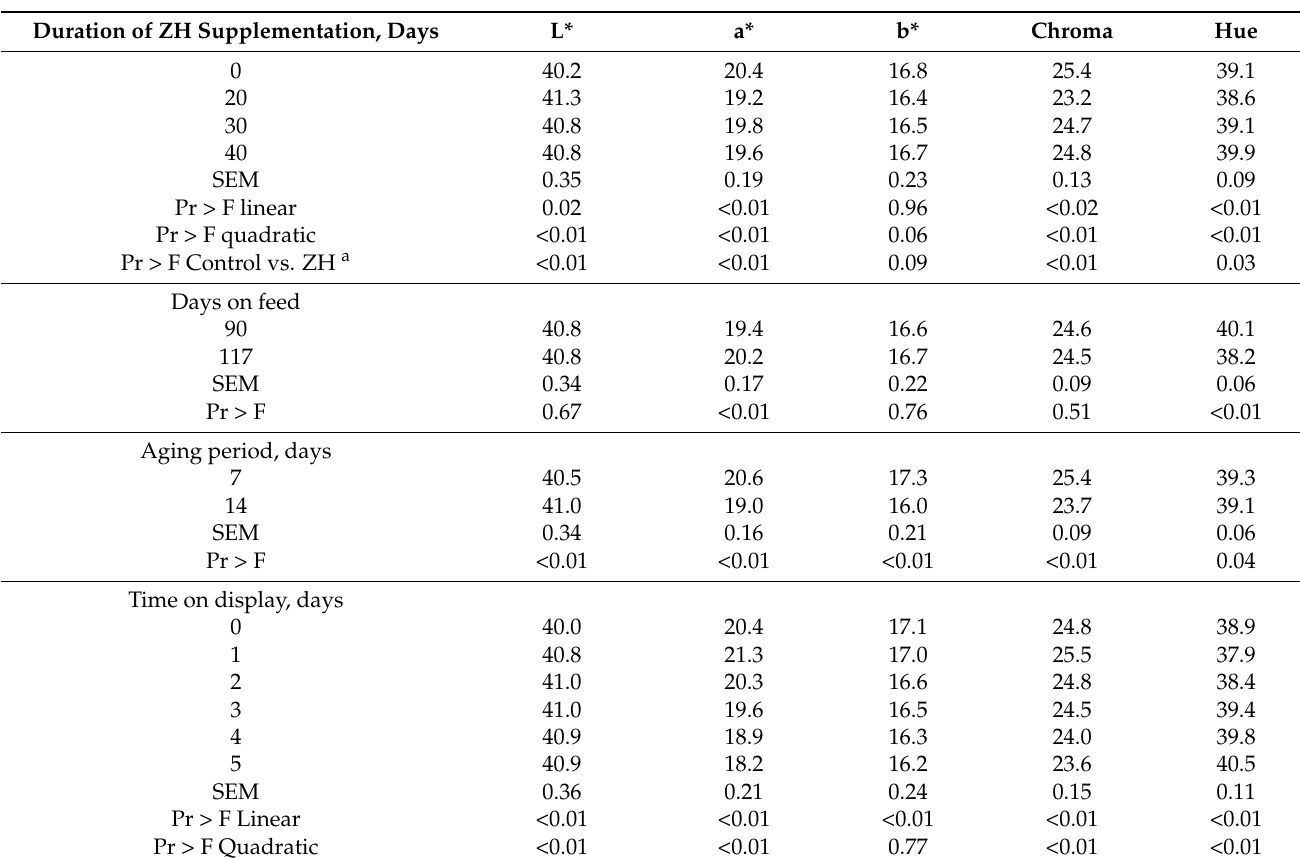
Table 4. Least square means, standard error of the mean (SEM), and probabilities (Pr > F) of color attributes according to the duration of zilpaterol hydrochloride (ZH) supplementation, days on feed, aging period, and days on display. Duration of ZH Supplementation,